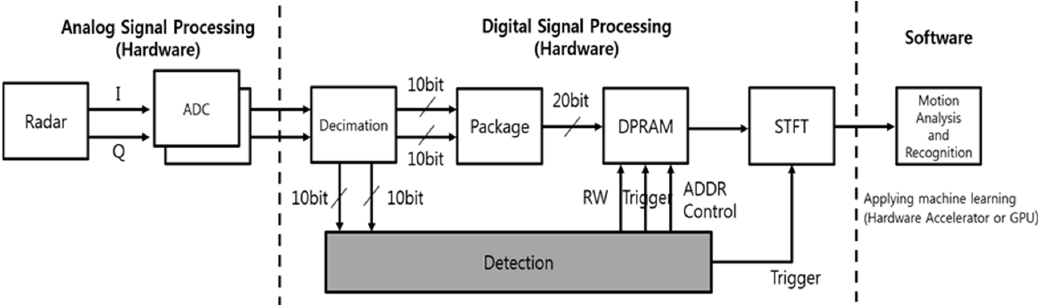
Figure 1. Diagram of Hand Gesture Recognition System Using CW radar Sensor.